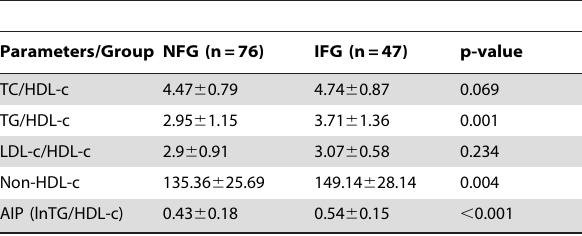
Table 5. Coronary atherogenic lipid risk factors of NFG and IFG